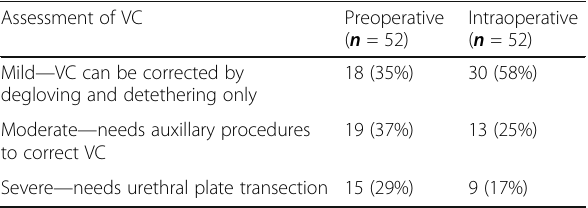
Table 4 Assessment of chordee based on